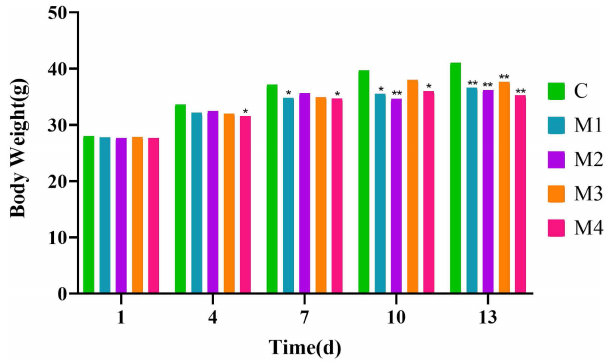
Figure 2. Effects of adenine combined with Folium sennae modeling on the body weight of diarrhea mice. Data were expressed as mean ± standard deviation, n = 6, * P < .05, ** P <